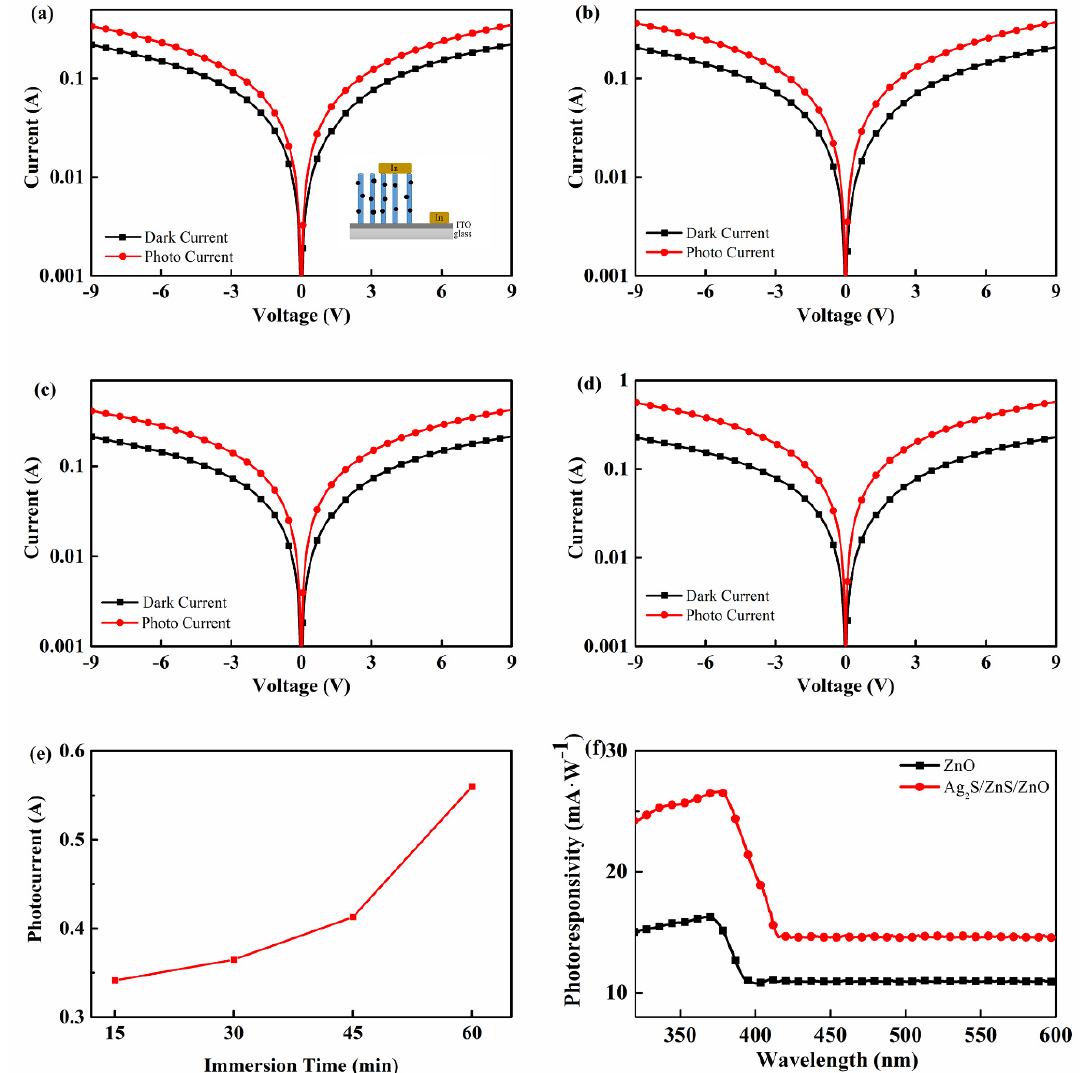
Figure 7. ( a )–( d ) I-V characteristics of photodetectors with various immersion time (( a ) 15 min, ( b ) 30 min, ( c ) 45 min, and ( d ) 60 min) under UV light; the figure inset ( a ) is a schematic diagram of the photodetector; ( e ) photocurrent of photodetectors with various immersion time under 9 V bias; ( f ) photoresponsivity of the photodetector with the immersion time of 60 min.